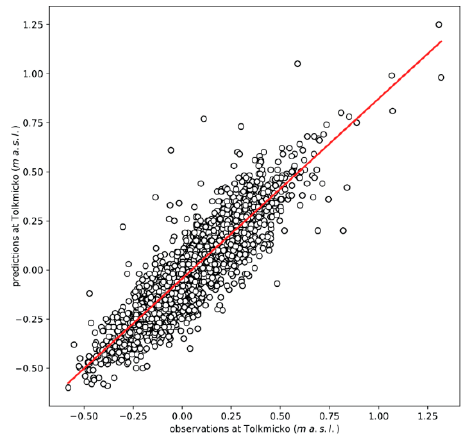
Figure 11. Observed and predicted water level at Tolkmicko station.